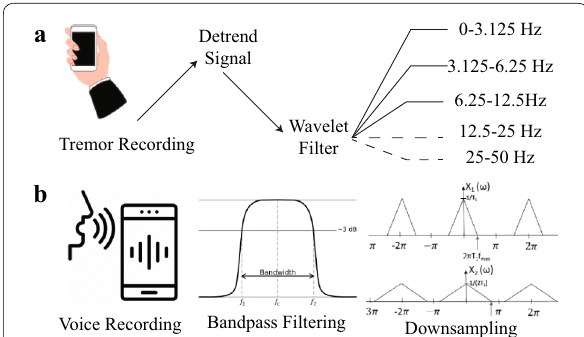
Fig. 1 Tremor and voice data acquisition. a Raw rest tremor data acquired by the accelerometer is first passed through a detrend filter which is then segmented in different frequency bands using wavelet filter-bank. b The vowel phonations captured by the recorder is passed through a band-pass filter which is then downsampled before feature